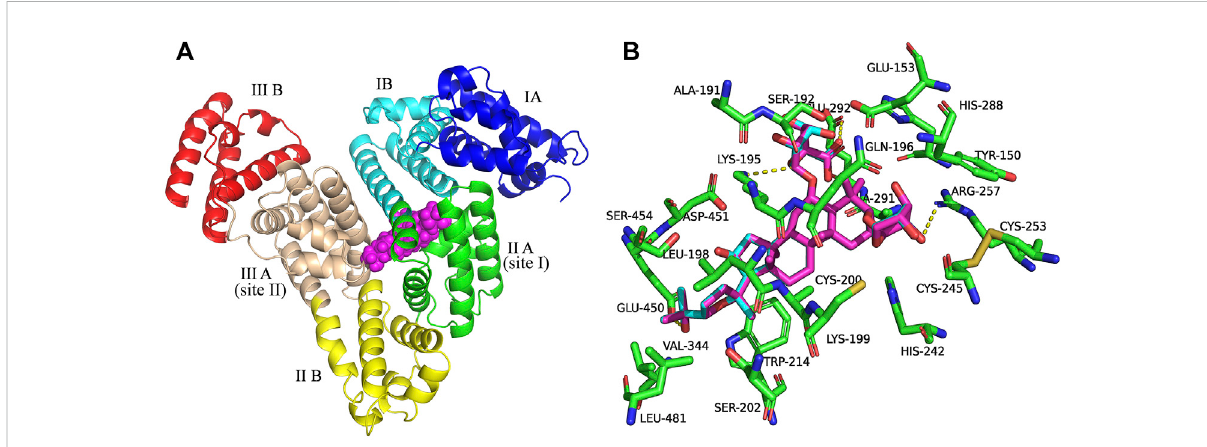
FIGURE 2 (A) Superposition of the structures of AGS IV and LS-102 (magenta spheres) within the active site pocket of human plasma albumin (HSA) (PDB ID: 1H9Z). Cartoon representation of HSA showing the six subdomains remarked with the following colors: IA, blue; IB, cyans; IIA, green; IIB, yellow; IIIA, wheat; IIIB, red. (B) The binding site was enlarged to show the superposition structures of AGS IV and LS102, with major amino acid residues (greensticks)surroundingligandswithin4 Å.ThecyanstructurestandsforAGSIVandmagentasisforLS-102,theyellowdottedlinesindicating hydrogen